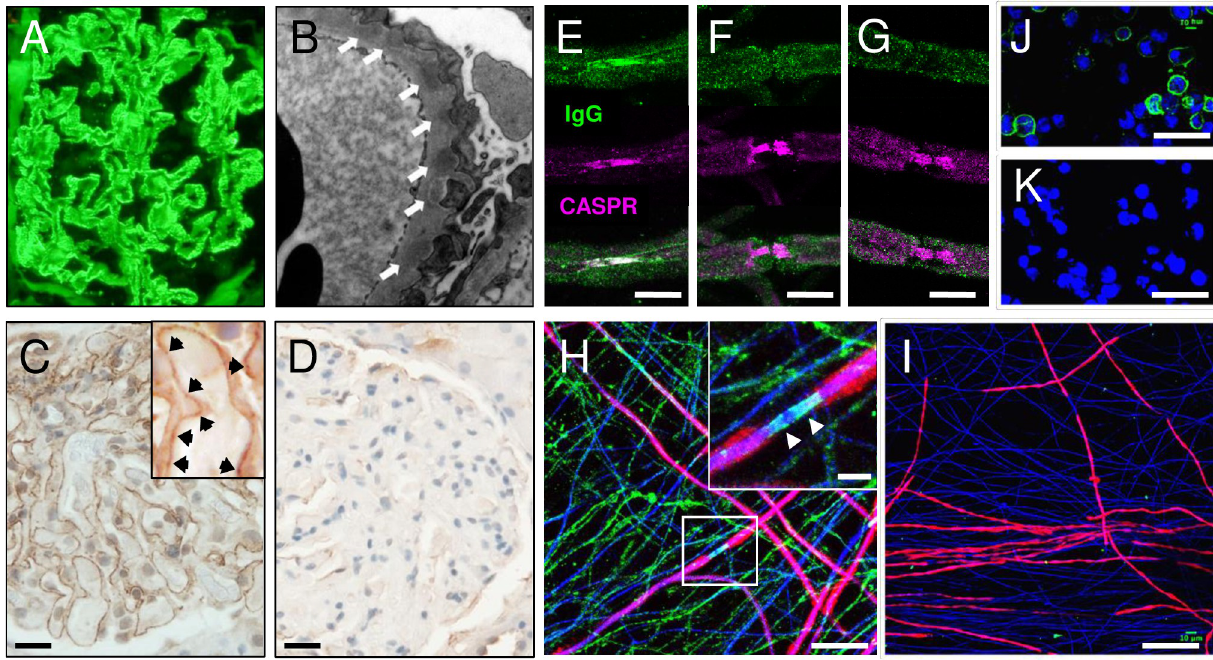
Fig 1. Contactin-1 immunoreactivity in kidney immune deposits and peripheral nerve tissue. A) Immunofluorescence of IgG deposition along glomerular capillary wall in anti-CNTN1 positive MGN patient kidney (P12 from S1 Table in S1 File). B) Electron microscopy reveals immune complex deposits on the extracapillary side of the glomerular basement membrane, visible as electron dense material (white arrows). C) Diaminobenzidine immunohistochemistry for CNTN1 is observed along the basement membrane of glomeruli from the same anti-CNTN1 positive MGN patient. Higher magnification image of a glomerulus demonstrating enrichment of CNTN1 in deposits lining the thickened basement membrane, characteristic of primary MGN (inset, black arrows). Equivalent results were obtained from biopsies of three further patients (S5 Fig). D) No CNTN1 labelling was observed in biopsy sections from an anti-PLA 2 R-positive patient with MGN. Scale bars in C-D, 20 μ m. E-G) Labelling of the paranode in teased fibres from mouse sciatic nerve with IgG (green) from pre-treatment anti-CNTN1-positive human sera (E) is abrogated post-treatment (F) and absent in healthy control sera (G). Bound human IgG co-localises with CASPR at the paranode (magenta). Scale bars, 10 μ m. H) Human IgG binding (green) to myelinated co-cultures treated with patient sera sampled before steroid treatment. Cultures were permeabilised with methanol prior to sera incubation. Note diffuse axonal pattern and paranodal localisation of human IgG (green) (arrowheads in inset). Myelin basic protein (MBP, red) indicates myelin, and neurofilament (NF200, blue) indicates axons. Scale bar, 25 μ m (5 μ m in inset) I) Loss of human IgG binding (green) to myelinated co-cultures treated with patient sera sampled after steroid treatment. Scale bar 50 μ m. J, K) CNTN1-transfected HEK293 cells (CBA) treated with patient sera sampled before (J) and after (K) steroid treatment. Serum titration in CNTN1 CBA shows a fall of anti-CNTN1 titre from 1:6400 to negative subsequent to steroid treatment. Scale bars, 50 μ